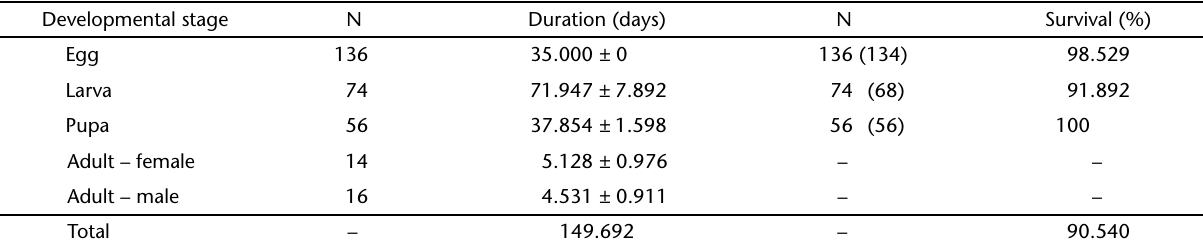
Table I. Mean duration, standard error and percent survival of M. cruenta . Larvae were fed mate tea, and maintained under 25 ± 1ºC temperature; 70 ± 10% relative humidity and 14 hours of photophase.